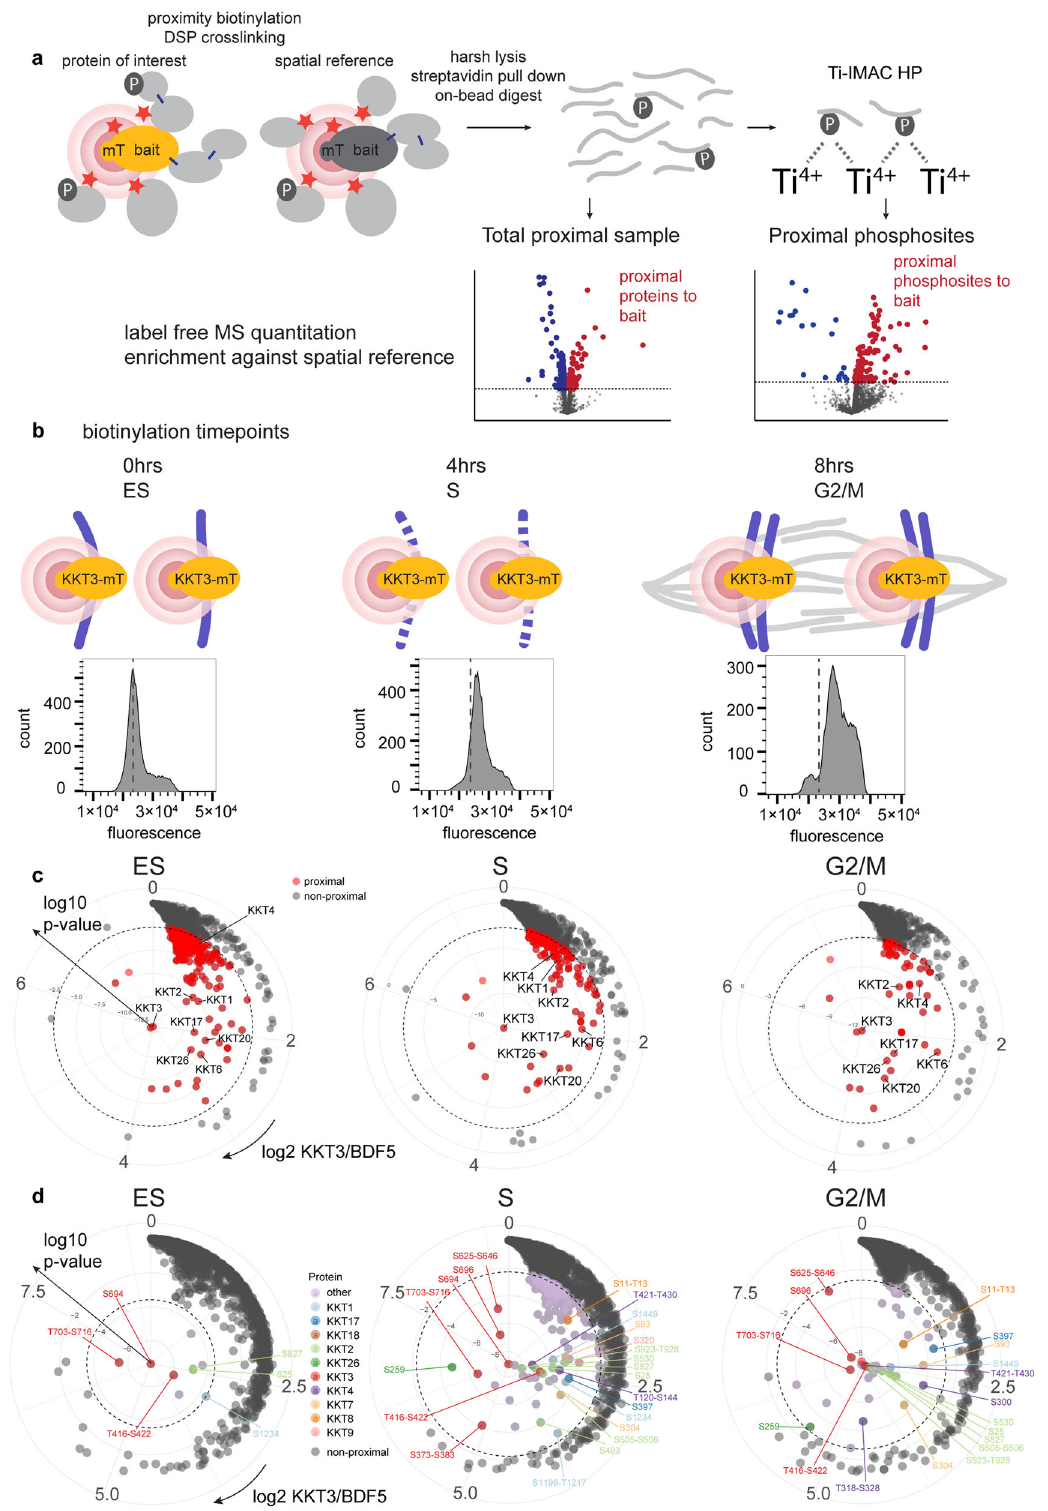
(Fig. 2c middle and right plots). KKT2 and KKT17 have indeed been shown to be constitutively present at the kinetochore in T. brucei . Our proximity data showed that KKT4 and KKT20 became 1.4-fold and 2.4-fold more enriched, respectively, through the cell cycle. KKT4 is the only kinetoplastid kinetochore protein demonstrated to bind microtubules and, therefore, likely plays an important role in attaching the kinetochore to the mitotic